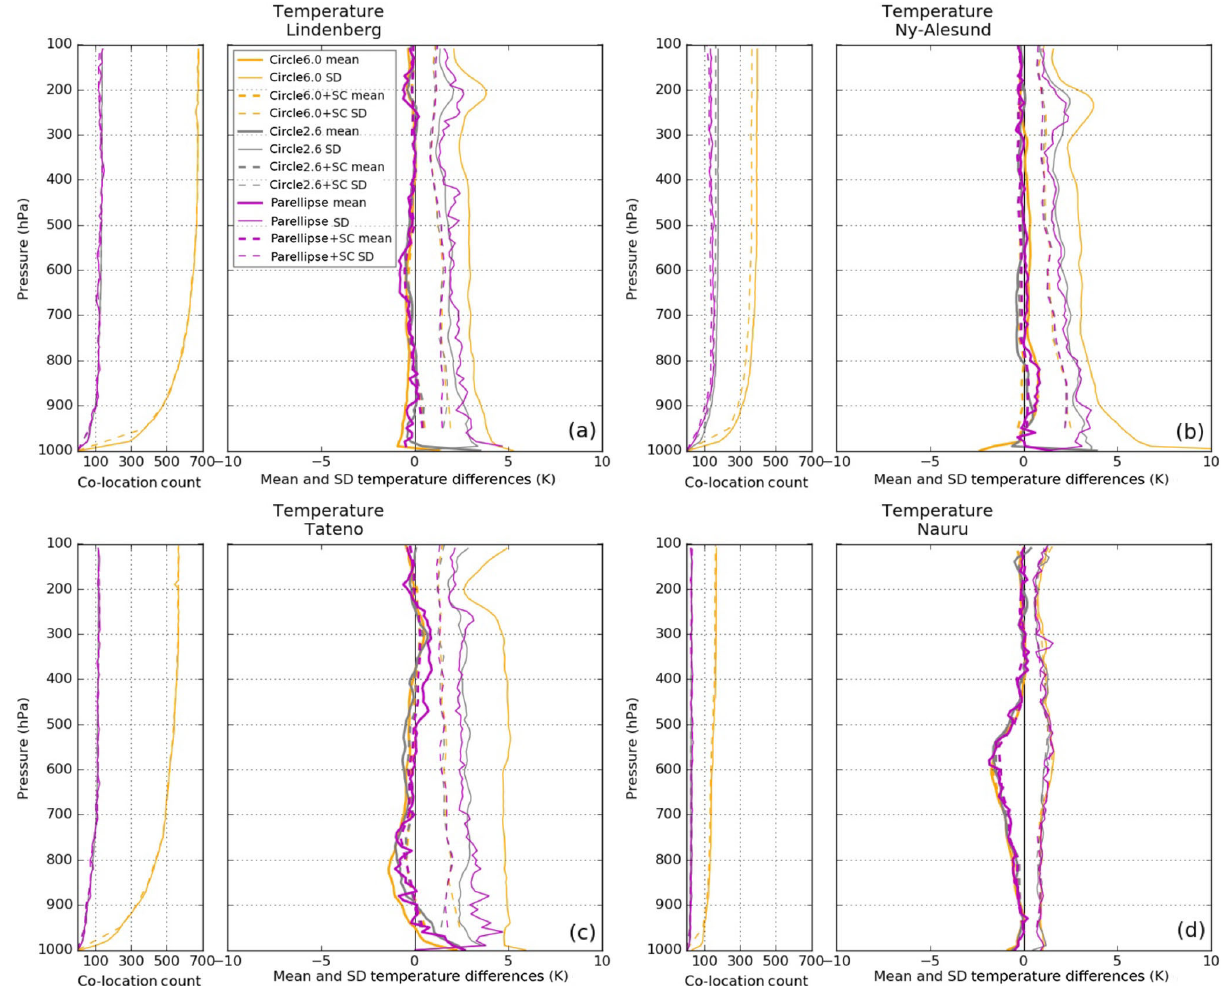
Figure A2. Same as Fig. A1 for